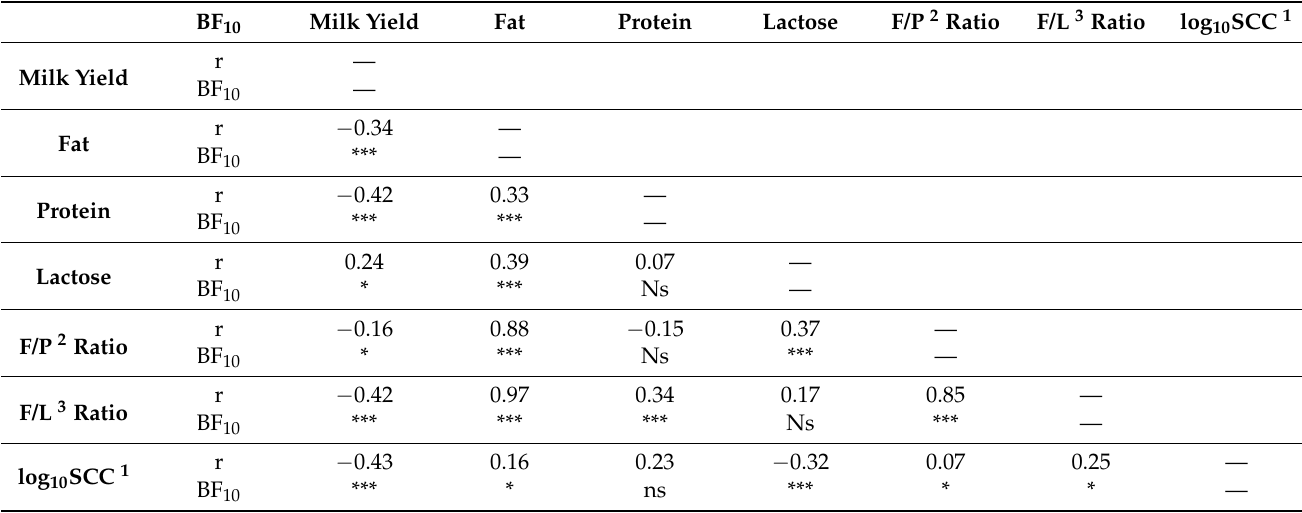
Table 6. Bayesian correlation coefficients for milk variables in Nera di Verzasca goat breed. Asterisks evidence the significance of BF 10 as reported in the